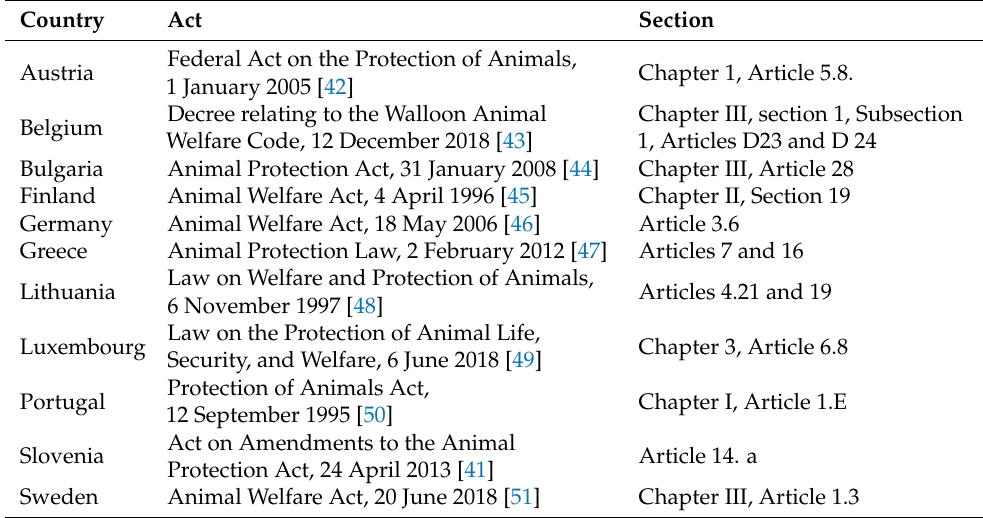
Table 2. Sections of animal welfare acts or codes that mention filming by country